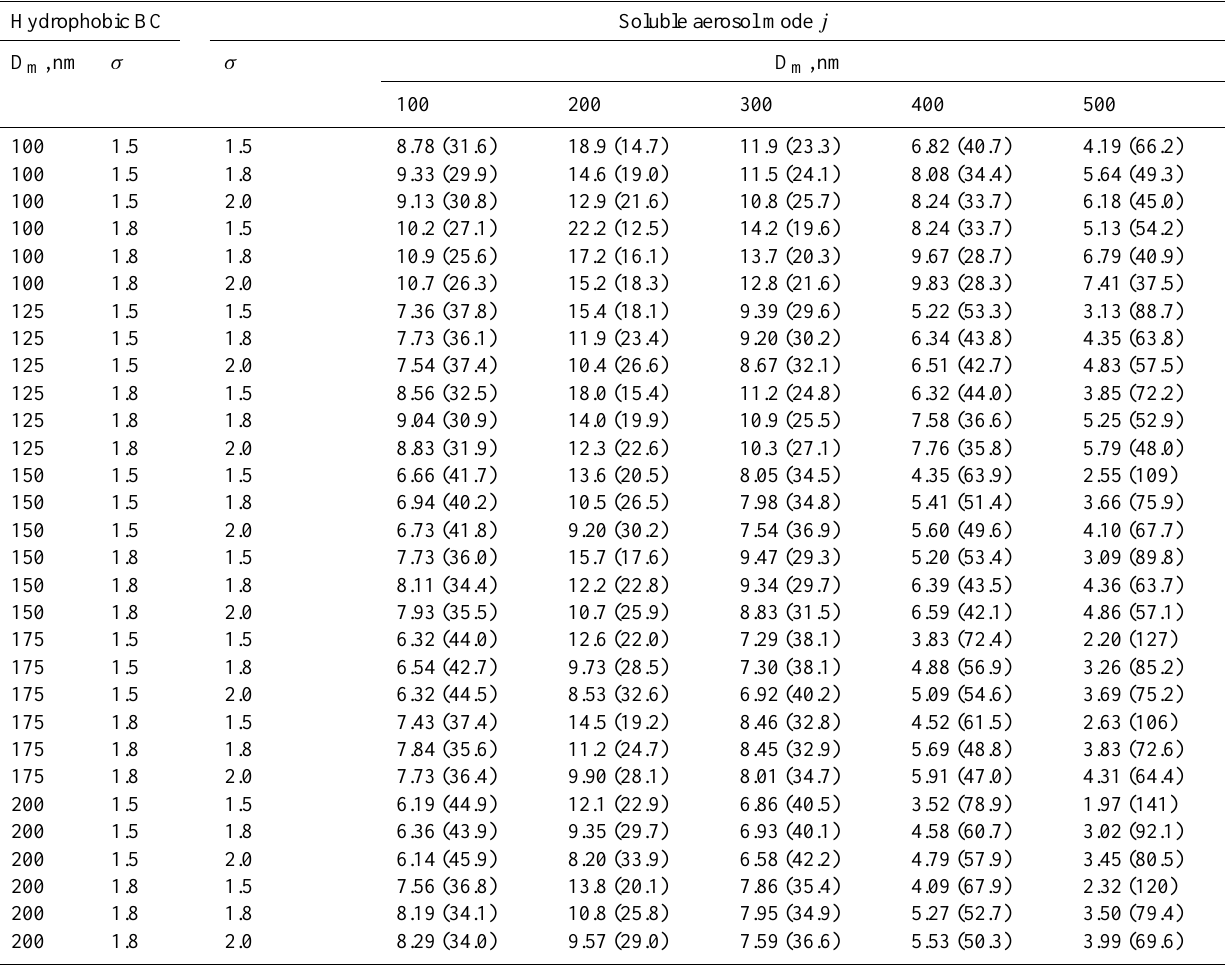
Table 3. Summary of the k coag.,j values for several combinations of the D m and σ values of hydrophobic BC and soluble aerosol mode j and the corresponding conversion time of BC aging due to coagulation over the source regions as examples. ∗ Hydrophobic BC